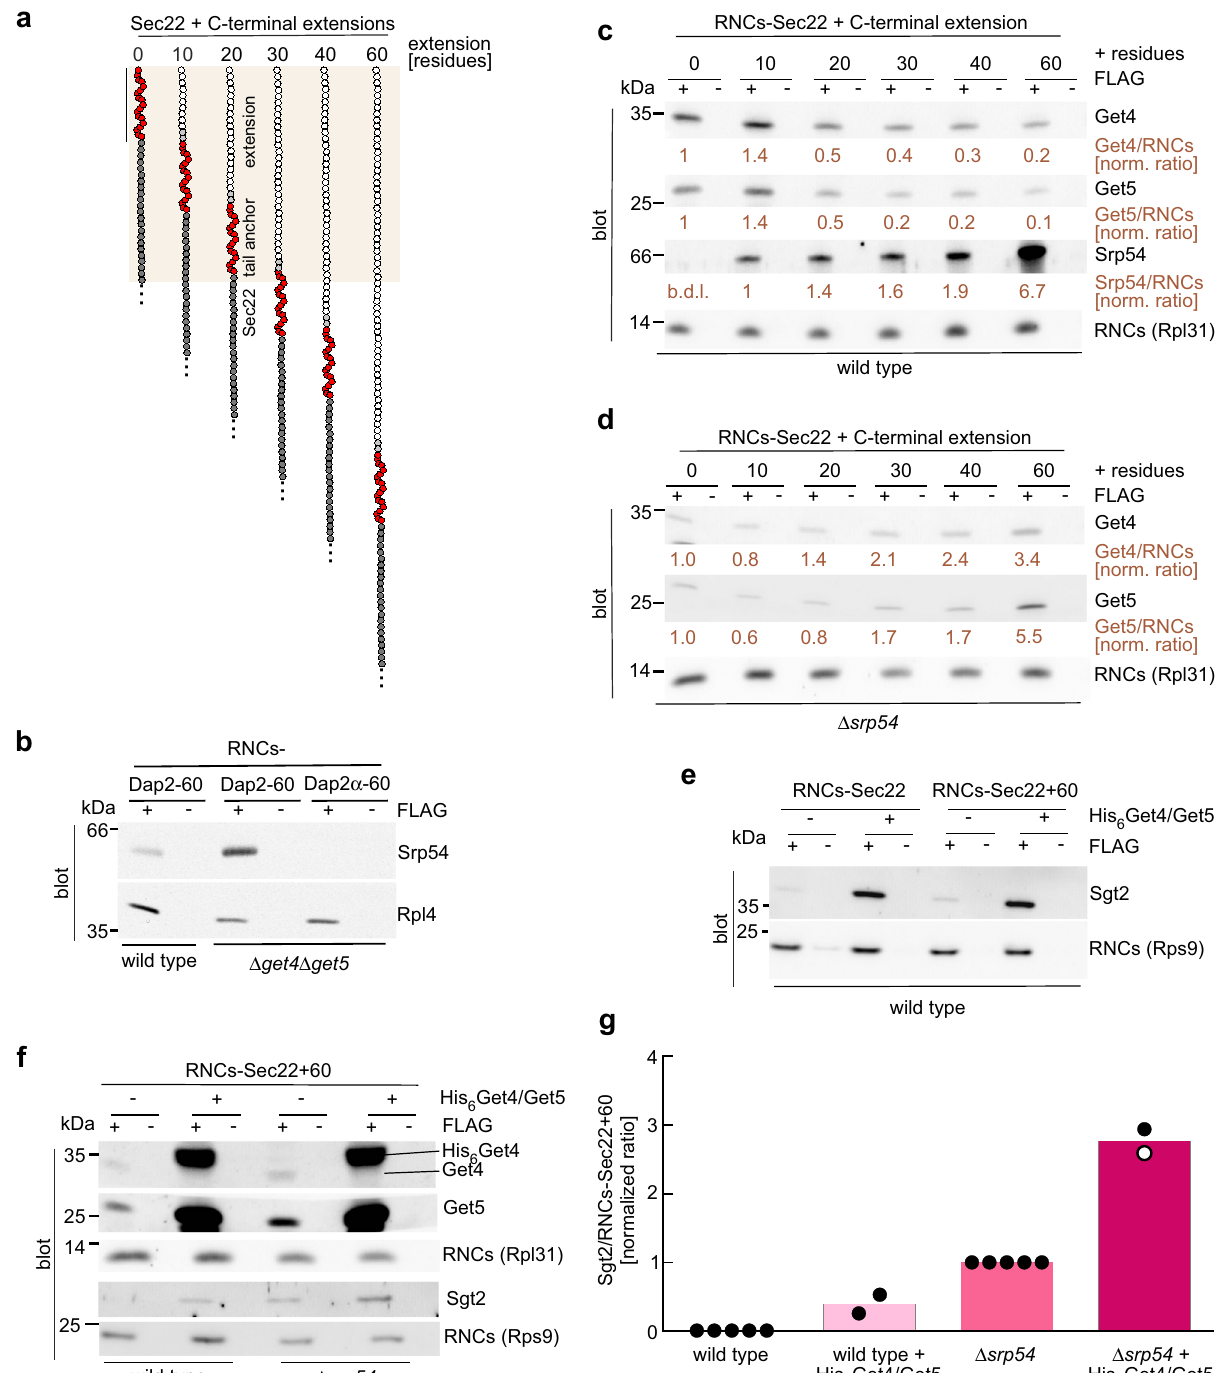
(Supplementary Fig. 5e). To investigate TA recognition during peptide release, we produced a ribosome-released TA protein by programming the yeast translation extract with an mRNA encoding full-length Sec22 including the stop codon (Supplemen- tary Fig. 5f). We fi rst assessed how much Sgt2 or SRP was bound to released Sec22 compared with nascent Sec22 + 60. To control for equal loading, released Sec22 and nascent Sec22 + 60 were labeled with [ 35 S]-methionine (Fig. 5d). Consistent with previous data 1,5,15,16 , Sec22 released upon translation was mainly bound to Sgt2 (Fig. 5d and Supplementary Fig. 5g and h), whereas nascent Sec22 + 60 was mainly associated with SRP (Fig. 5d). These data